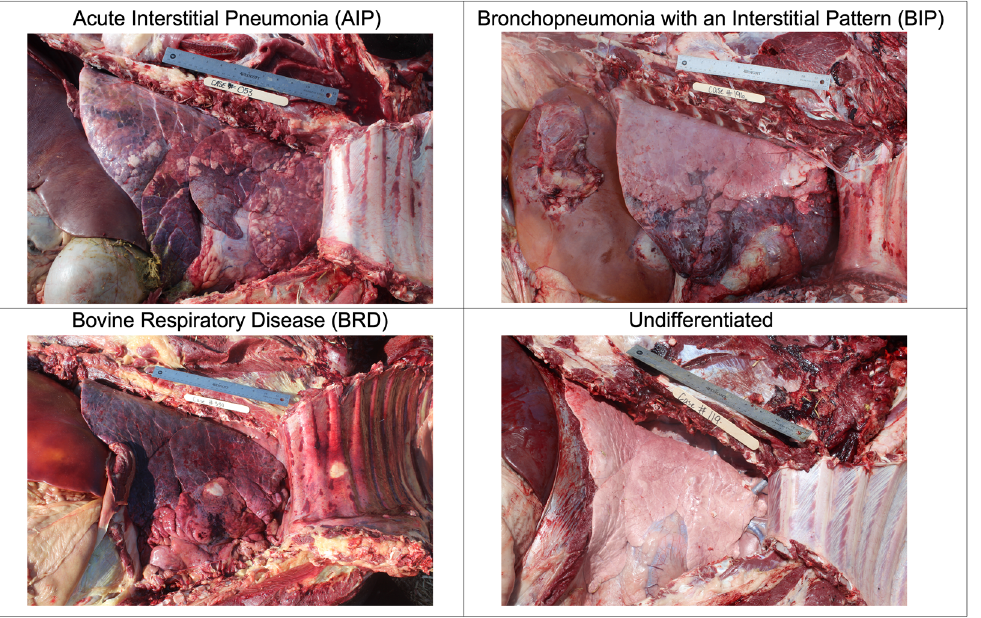
Figure 1. Image examples of the four possible gross diagnoses including acute interstitial pneumonia (AIP); bronchopneumonia with an interstitial pattern (BIP); bovine respiratory disease (BRD); and other lung diagnoses that were not AIP, BIP, or BRD (undifferentiated, i.e., embolic pneumonia, healthy lungs, and other diagnoses).